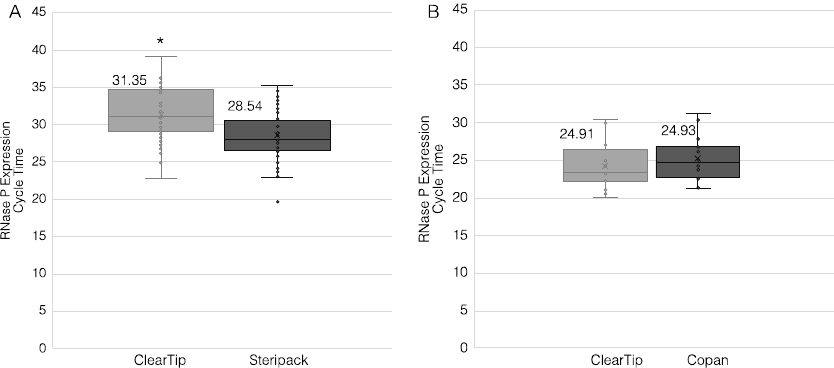
Figure 4. ClearTip TM clinical validation for RNase P detection. Two independent clinical studies were performed to quantify the ability of the ClearTip TM swab to pick up nasal cellular material in comparison to control flocked nasal swabs. ( A ) Clinical study at the CAPCaT University of Massachusetts Lowell showed a significant increase in cycle time for the detection of RNase P collected by ClearTip TM Swabs and Steripack Nasal Swabs ( p < 0.05). ( B ) Clinical study at Washington University St. Louis showed no statistical difference ( p = 0.945) in cycle time for the detection of RNase P collected by ClearTip TM Swabs and Copan Nasal Swabs. * Statistical difference against flocked NP control ( p < 0.05).